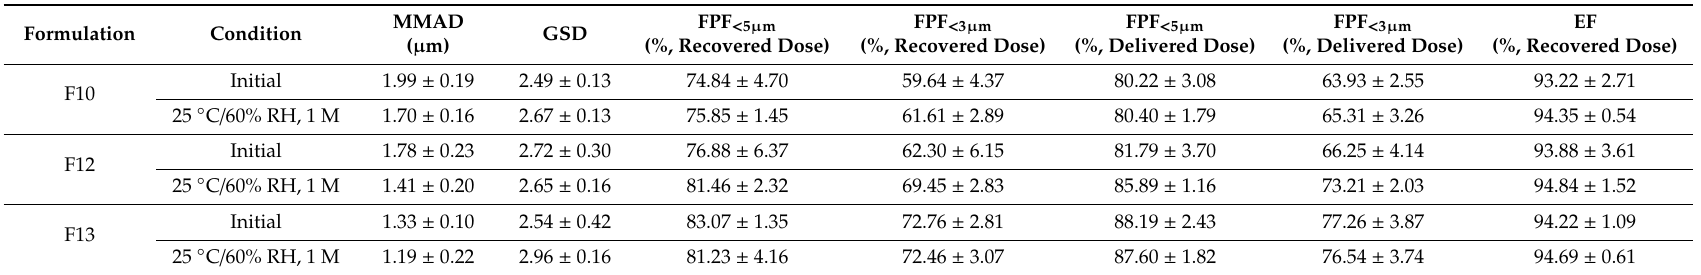
Table 3. Aerosol performance of TFF remdesivir powders after one month of storage at 25 ◦ C / 60% RH using a Plastiape ® RS00 high-resistance DPI at a flow rate of 60 L / min ( n = 3). (MMAD, mass median aerodynamic diameter; GSD, geometric standard deviation; FPF, fine particle fraction; EF, emitted